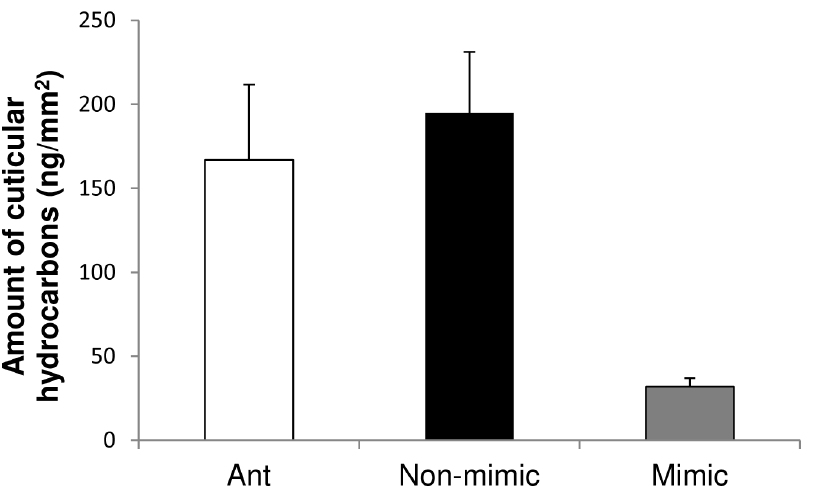
Figure 5. Ants ( Camponotusnearcticus ) and non-mimic spiders ( Paraphidippusaurantius ) have significantly higher levels of cuticular hydrocarbons than do mimics ( Peckhamiapicata ): Ant vs. mimic, Mann-Whitney U=20, Z=2.4, P 0.015; Non-mimic vs. mimic: Mann- Whitney U=16, Z=2.3, P=0.014).